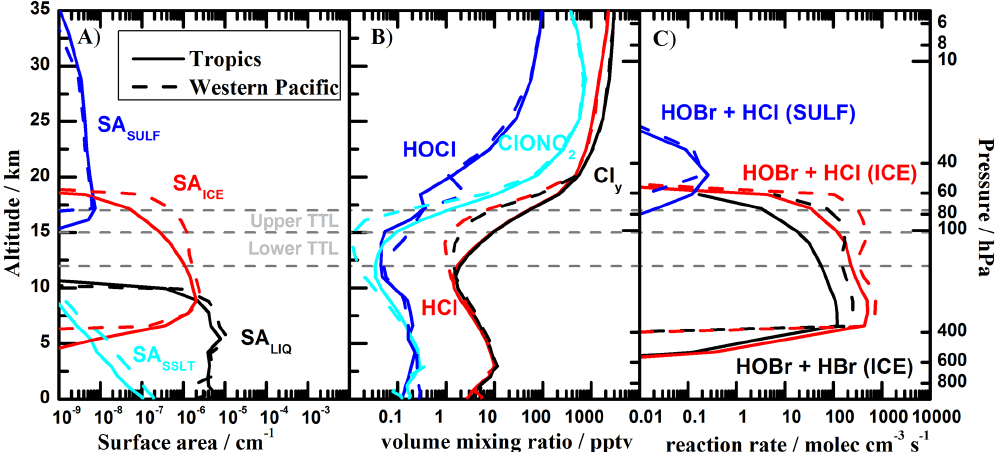
Figure 10. Vertical variation of CAM-Chem atmospheric constituents affecting the rate of heterogeneous reactions within the tropics (solid lines) and WP region (dotted lines): (a) SA ICE , SA LIQ , SA SULF and SA SSLT ; (b) average vertical profiles of HCl, HOCl, ClONO 2 and total inorganic chlorine (Cl y ) ; (c) heterogeneous reaction rates over different types of